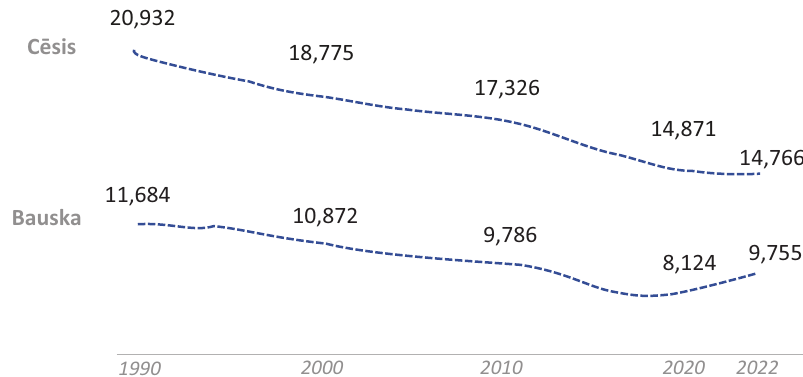
Figure 3. Population dynamics in Bauska and Cēsis. Source: Central Statistical Bureau of Latvia (2022). there are different people living [here], visibly there are many poor [people] living in the